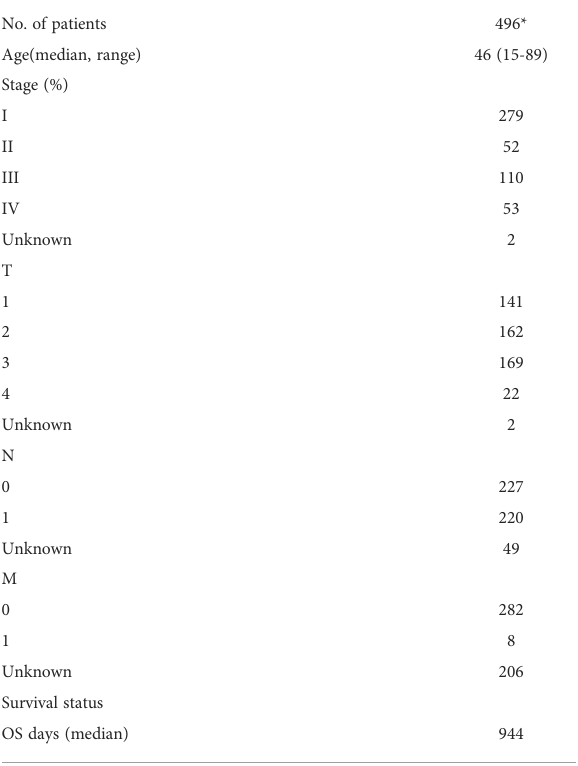
TABLE 1 The baseline clinical characteristics of the thyroid cancer patients in this